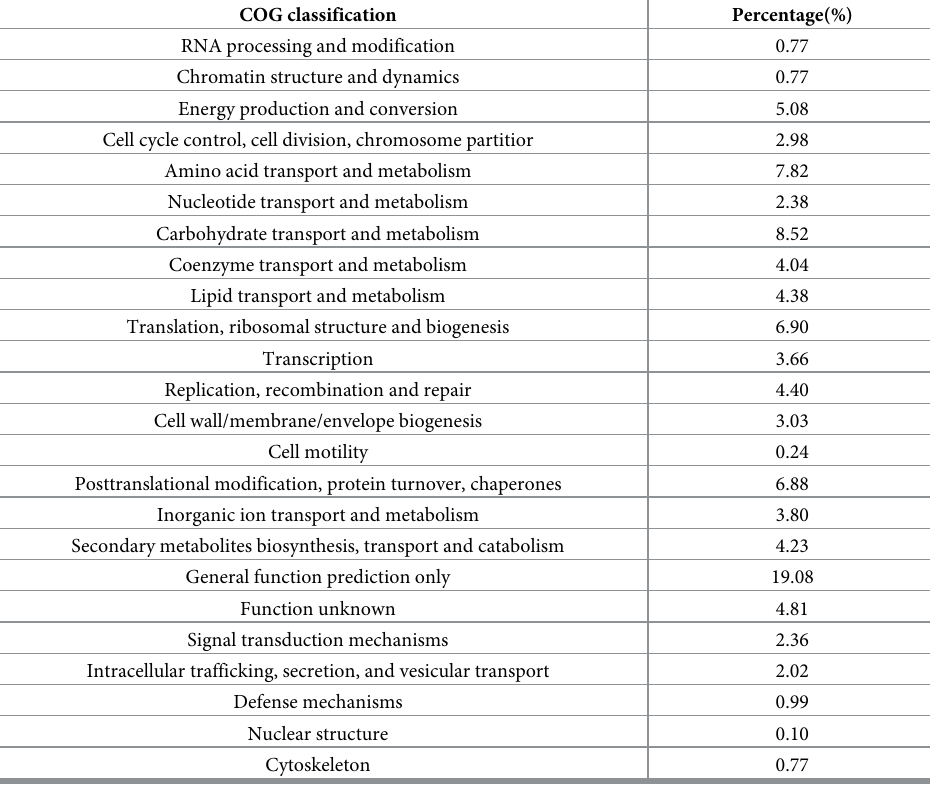
Table 2. COG classification of predicted genes encoding proteins with annotated functions of M . purpureus CSU-M183